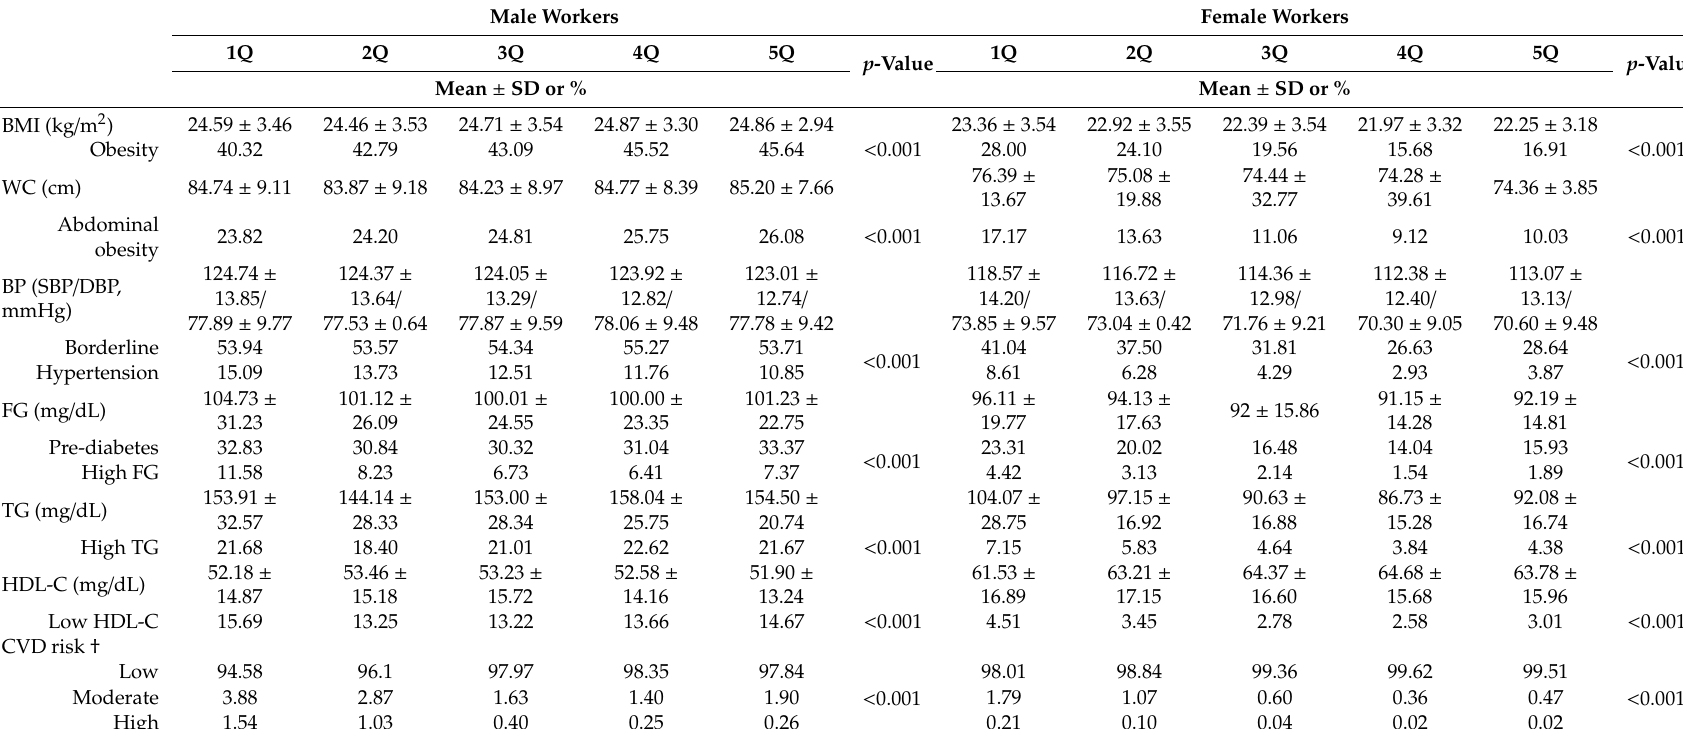
Table 6. Sex di ff erences of CVD-related health status by